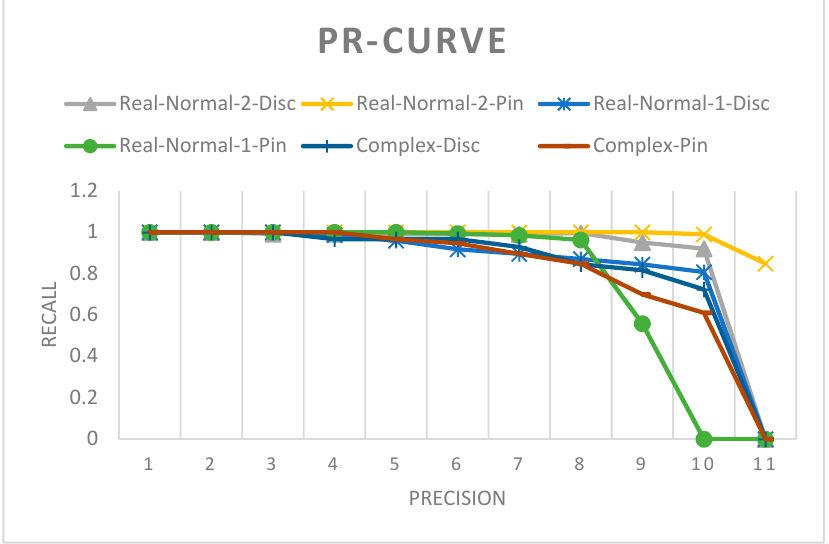
Figure 16. Precision recall curve of YoloV4 for normal insulator detection model for different test datasets.